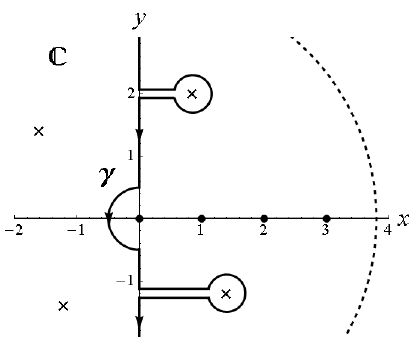
Figure 2. The singular points of the function Γ ( − z ) on the complex plane C are marked with a dot “ • ”. The possible singular points of the function f ( z ) are marked with “ × ”. The contour γ is supposed to be closed on the right